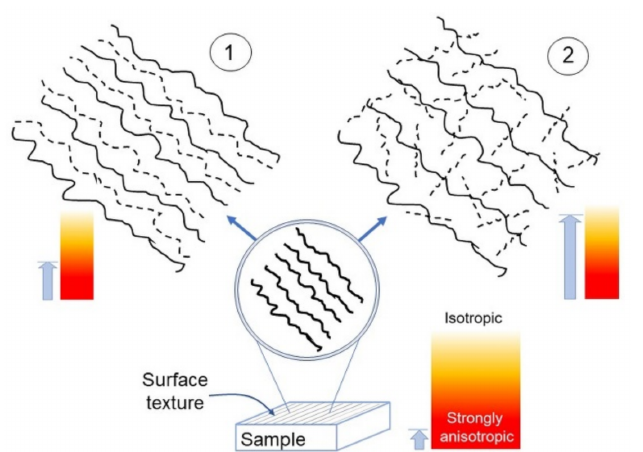
Figure 8. Sketch of the anisotropy appearance in a surface possessing a single lay (bottom), upon magnification in the case 1 (top left) and 2 (top right). The light blue arrows roughly indicate the corresponding anisotropy